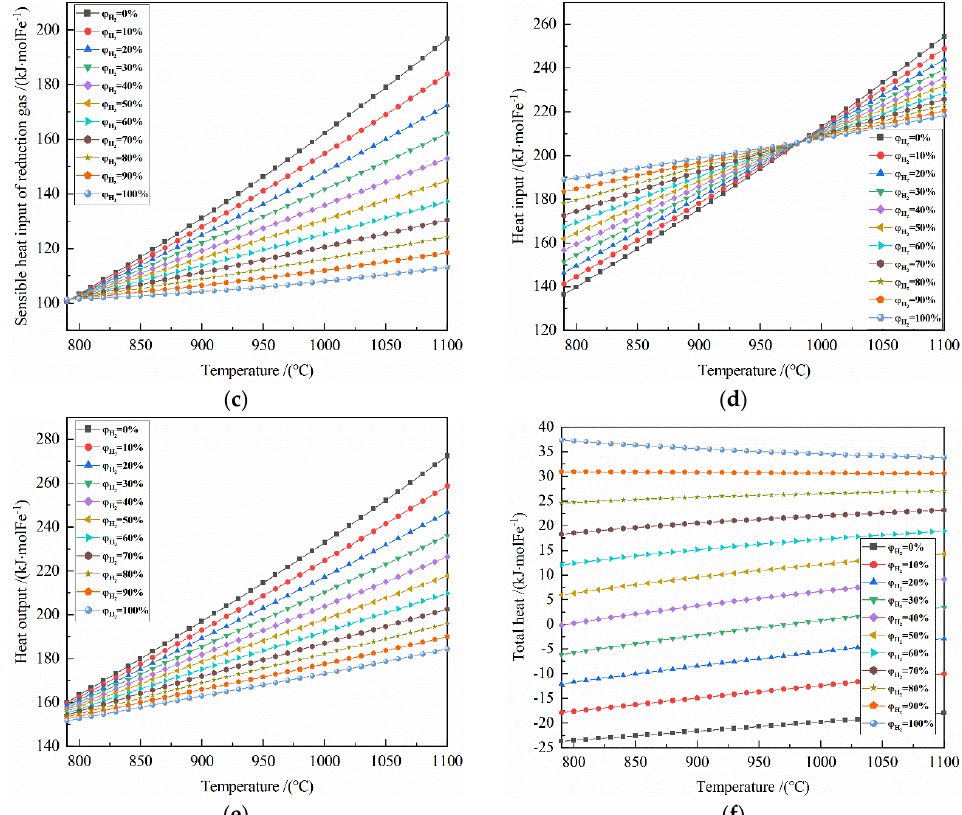
Figure 7. The effect of reduction temperature on energy consumption of the reduction of 0.5 mol Fe 2 O 3 at 790–1100 ° С with varied H 2 concentrations: ( a ) reaction heat; ( b ) sensible heat input of solid Fe 2 O 3 ;